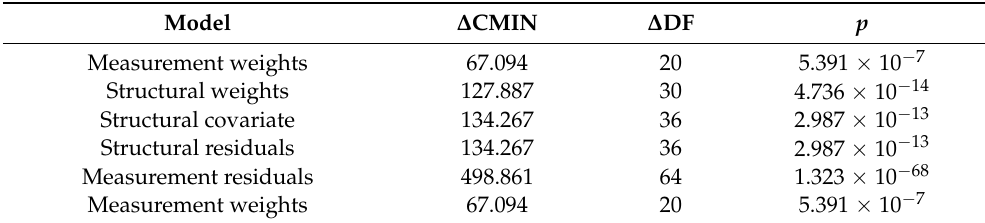
Table A6. Direct, indirect, and total effects of livelihood capitals and human settlements on agricul- tural land transfer.